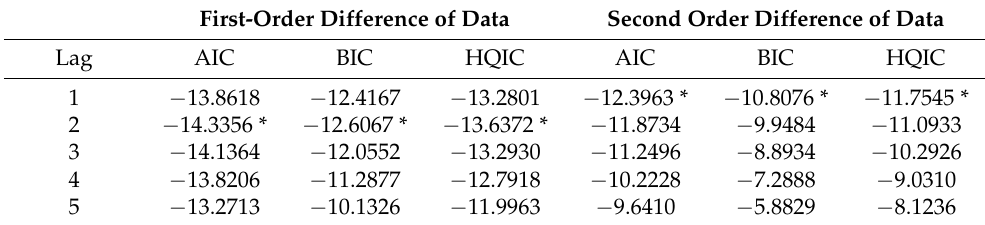
Table 5. Selection of optimal lag order.